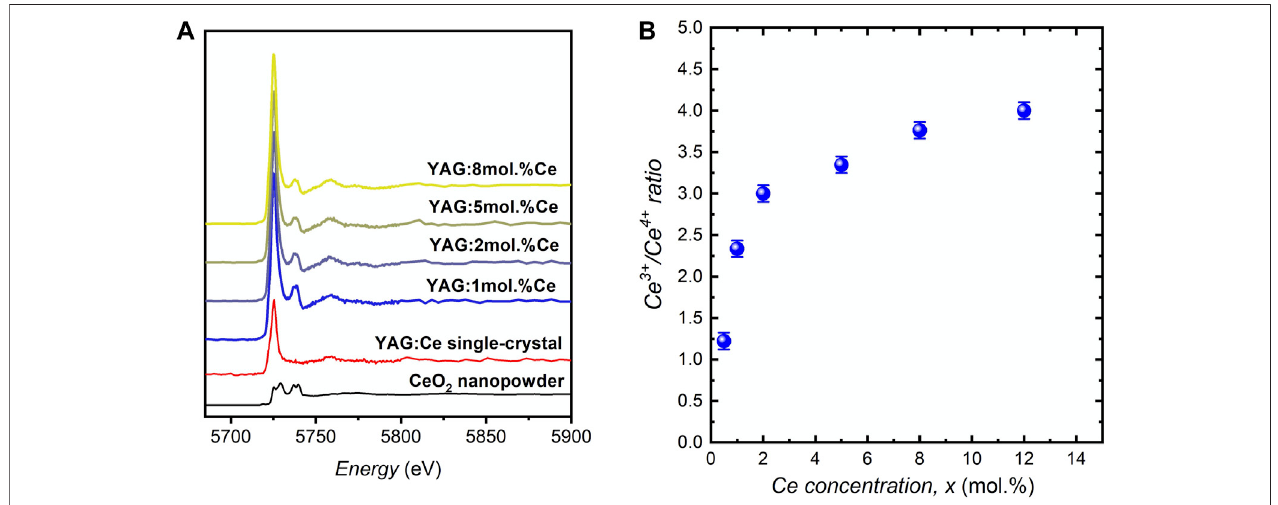
FIGURE 7 | (A) XANES spectra of YAG:xCe nanocrystals for different cerium concentrations and (B) Ce 3+ :Ce 4+ ratio calculated from the linear combination of reference spectra of CeO 2 nanocrystals and YAG:Ce single crystal doped with 1 mol.%